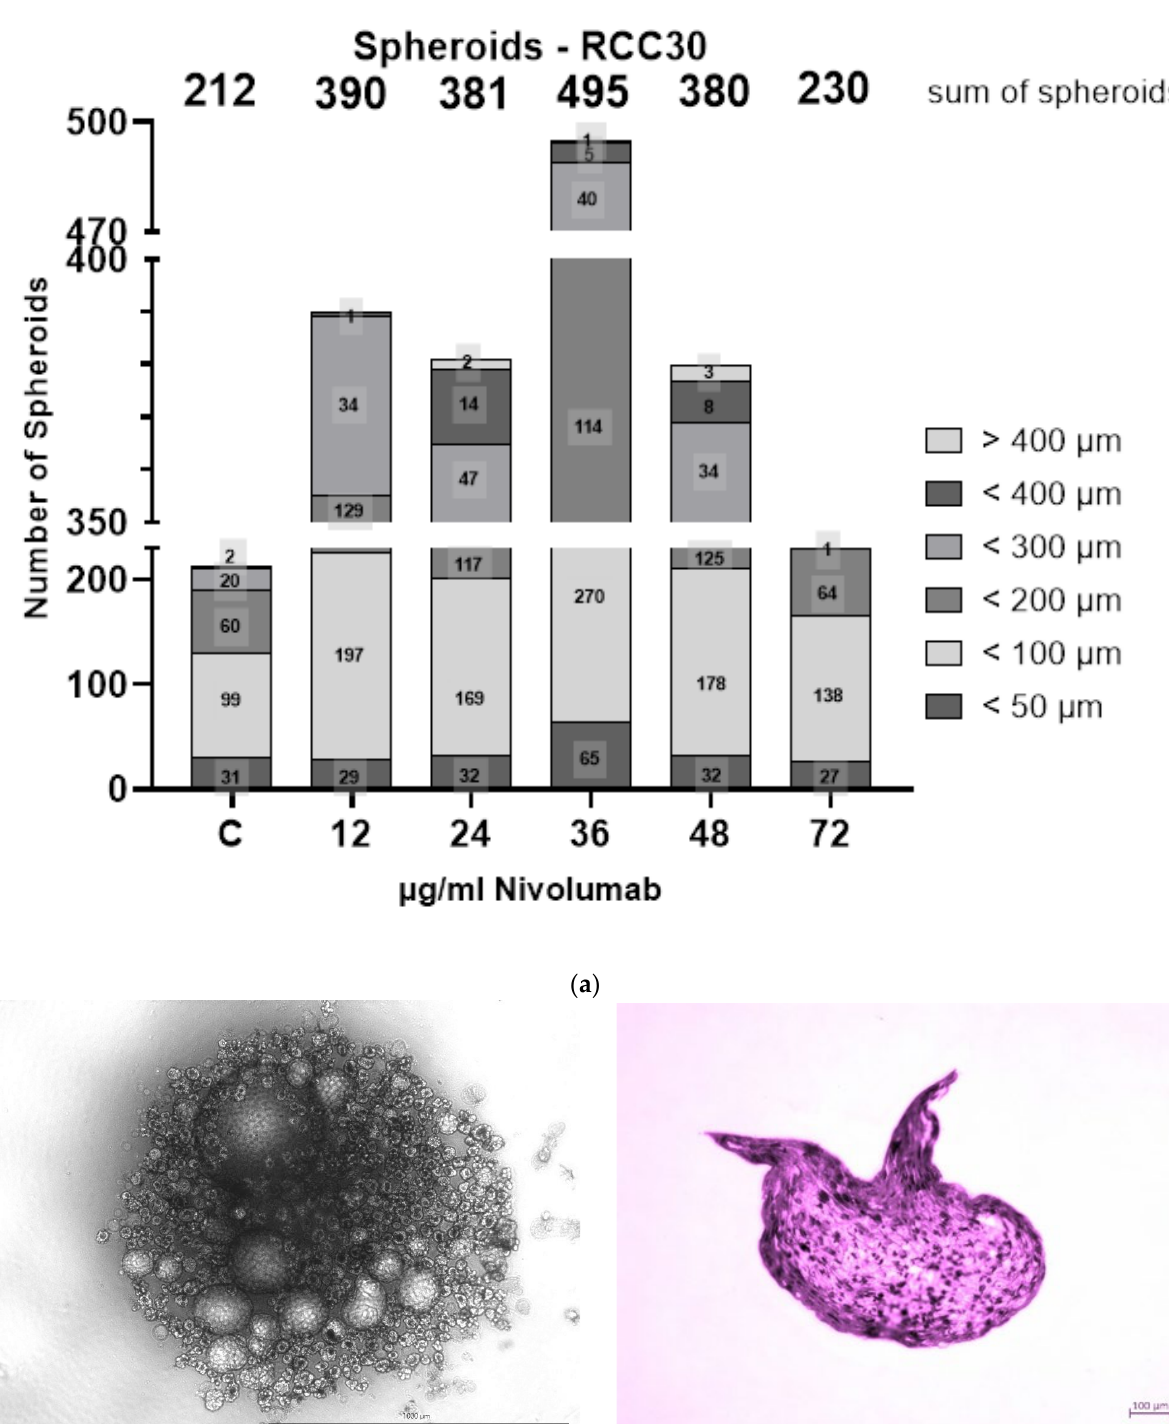
Nivolumab did not influence the expression of Cath B in any of the cell lines (not shown). We analyzed the activity of Cath B by normalizing the results after employing the specific inhibitor (included in the kit) and defining its results as “1”. Cath B activity was detected in three (RCC30, Caki-1 and RCC31) of four cell lines. The ACHN cell line